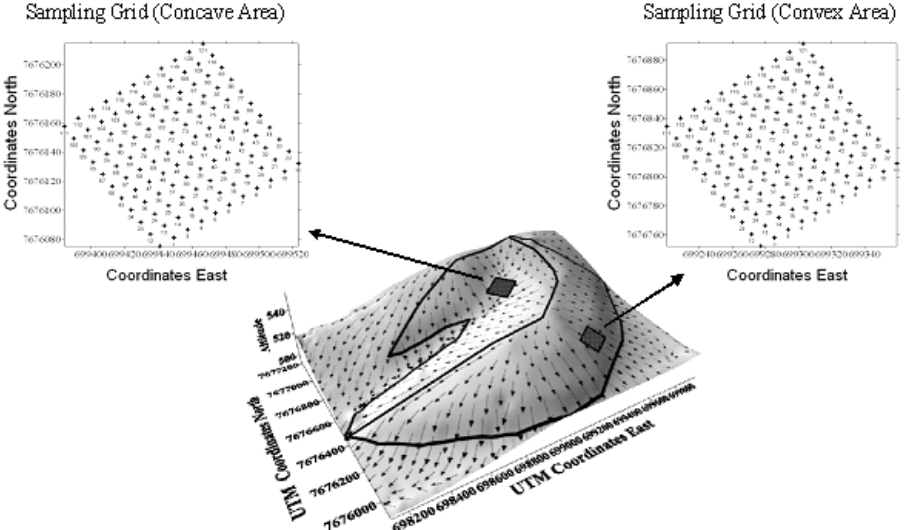
Figure 1. Digital Elevation Model (DEM) of the study area. Arrows indicate land modeling and water